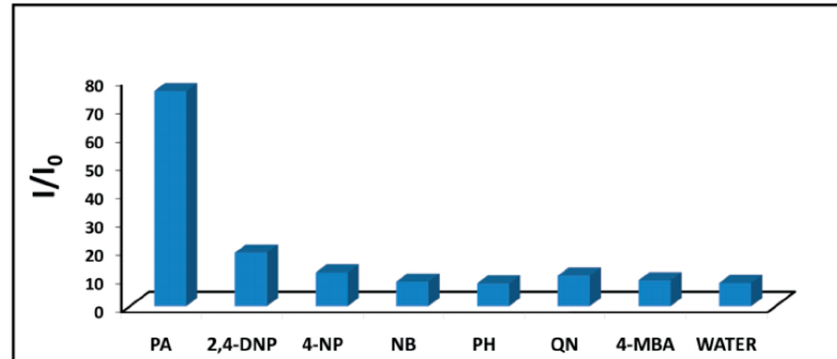
Figure 21. Increases in conductivity of the C-dot-PPy film in the presence of 2.0 μ L 1.0 mM